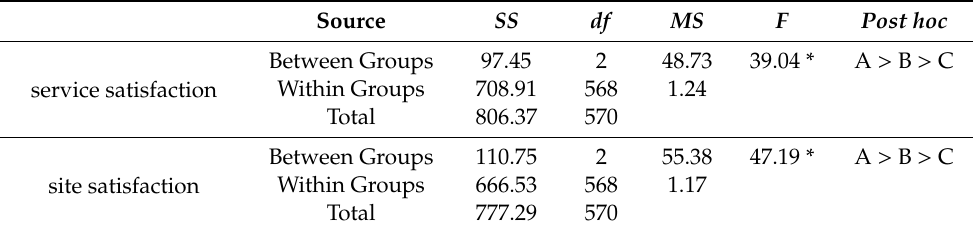
Table 5. Variance analysis of di ff erent levels of understanding in overall